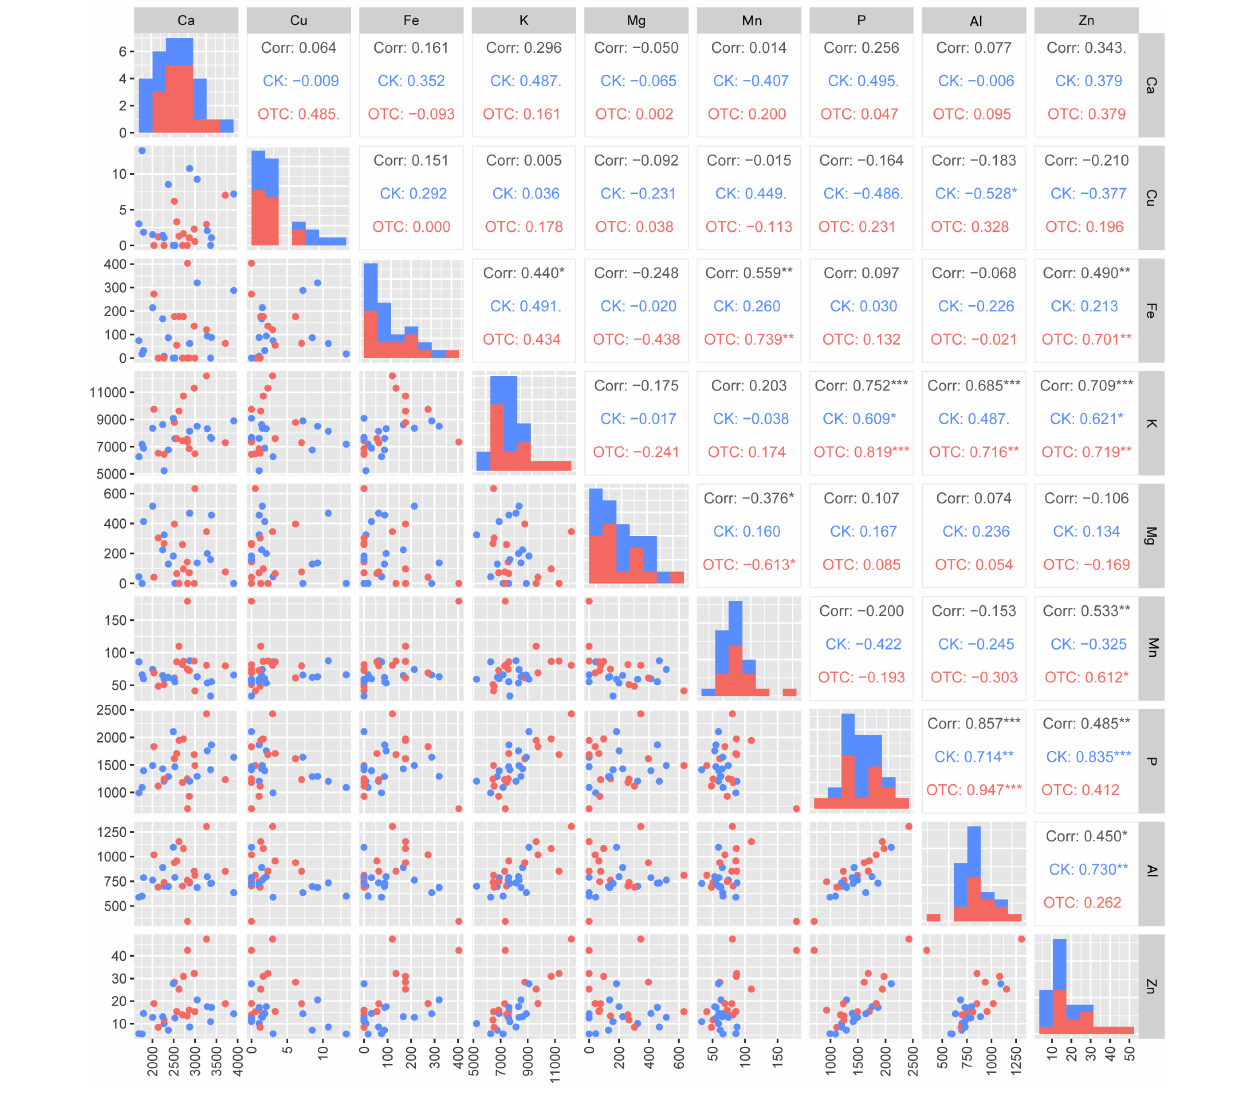
FIGURE 3 | Scatter matrix plot: relationship between needle elements in CK groups at the three attitudes, OTC groups at the three attitudes, and all groups include CK groups and OTC groups at the three attitudes. *0.01 < P ≤ 0.05; **0.001 < P ≤ 0.01; *** P <